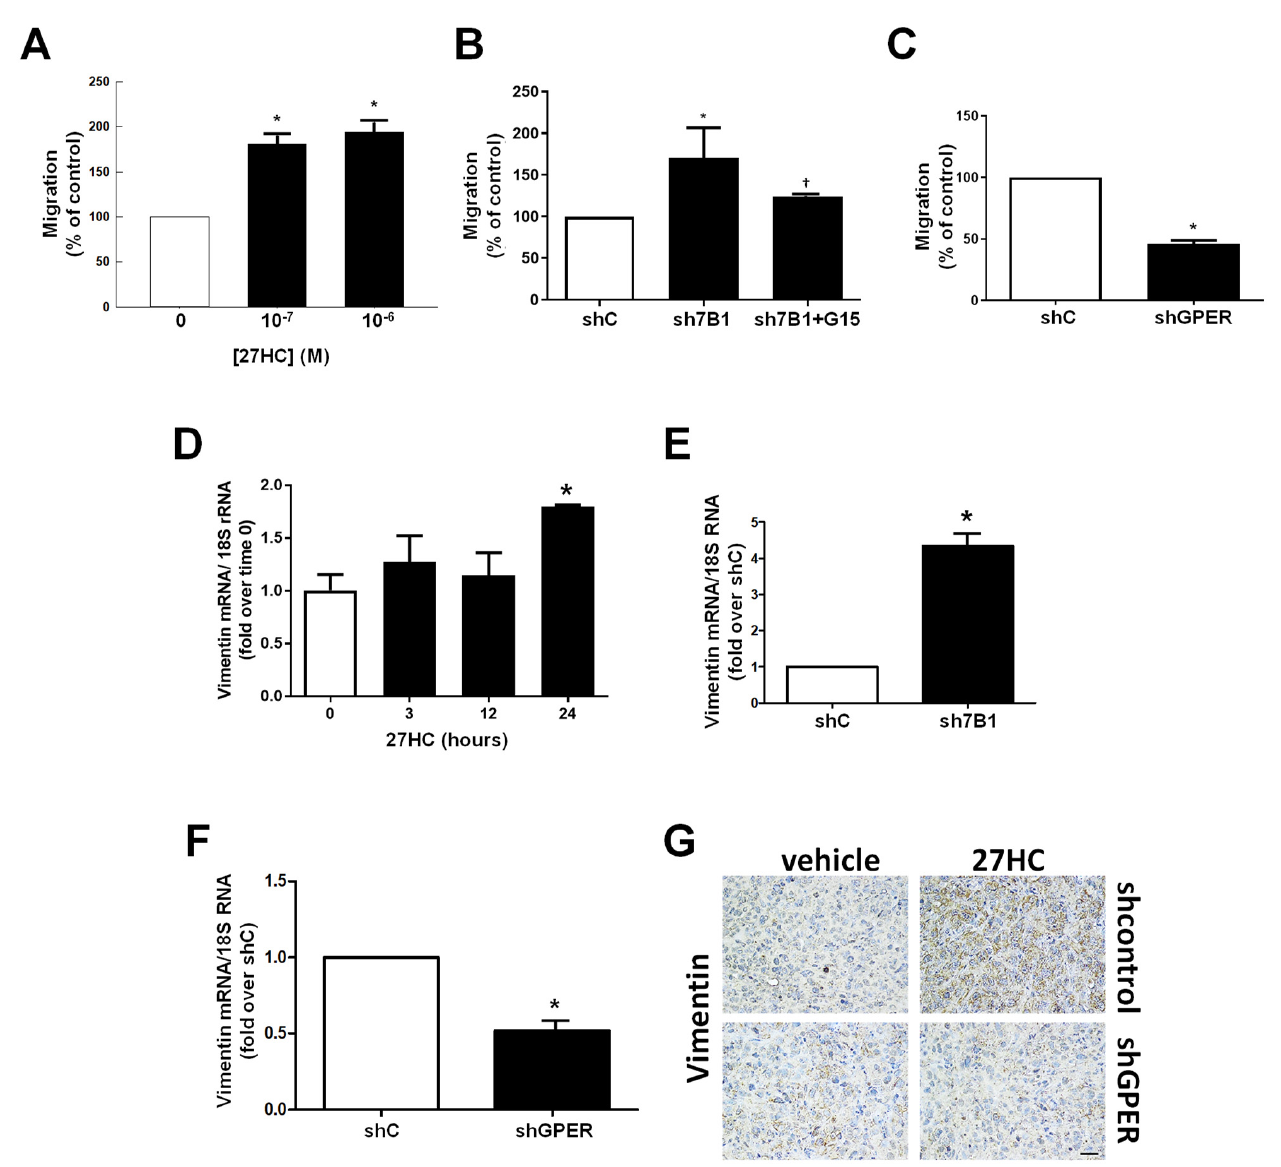
Figure 5. 27HC via GPR30 induces EMT to sustain ER − BC cell migration. ( A , C ) Counts of MDA- MB-231 ( A ), shcontrol (shC) and shCYP7B1 (sh7B1) cells +/ − G15 (10 − 6 M), ( B ) shC and shGPER cells ( C ) migrated through Boyden chambers. ( D – F ) . QPCR analysis of vimentin in MDA-MB-231 cells treated for the indicated times with 27HC (10 − 6 M) ( D ), shC and sh7B1 ( E ) shC and shGPER ( F ). ( G ) Vimentin abundance was evaluated by immunostaining in xenografts tumors of shcontrol or shGPER MDA-MB-231 cells. Images were obtained with a 20 × objective, scale bar 25 µ m. * p < 0.05 vs. basal (untreated cells) or shC cells; † p < 0.05 vs. sh7B1 cells.